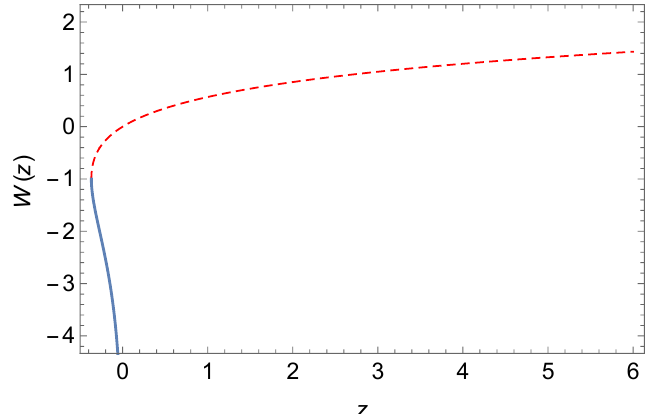
Figure 2: The Lambert function W . The dashed red line corresponds to the branch W whereas the blue line corresponds to the branch W − 0